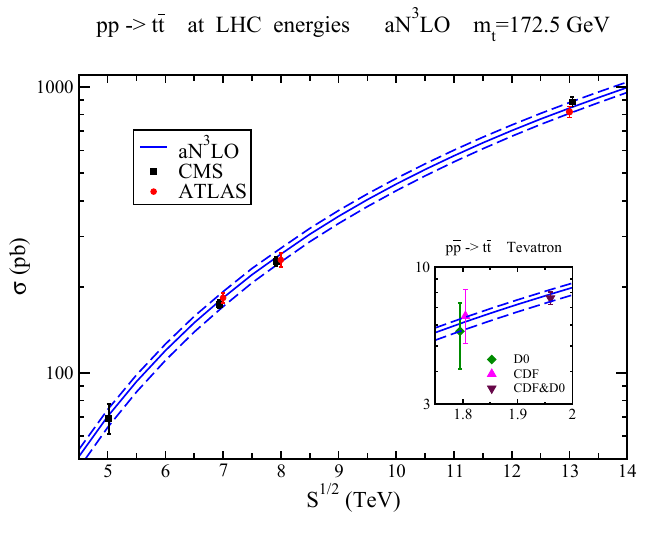
Figure 4. Top-antitop aN 3 LO cross sections compared with CMS data at 5.02 TeV [41] and with ATLAS and CMS data at 7 TeV [42, 43], 8 TeV [43, 44], and 13 TeV [45, 46] LHC energies. The inset shows the aN 3 LO cross section compared with CDF [47] and D0 [48] data at 1.8 TeV, and CDF&D0 combined data [49] at 1.96 TeV Tevatron